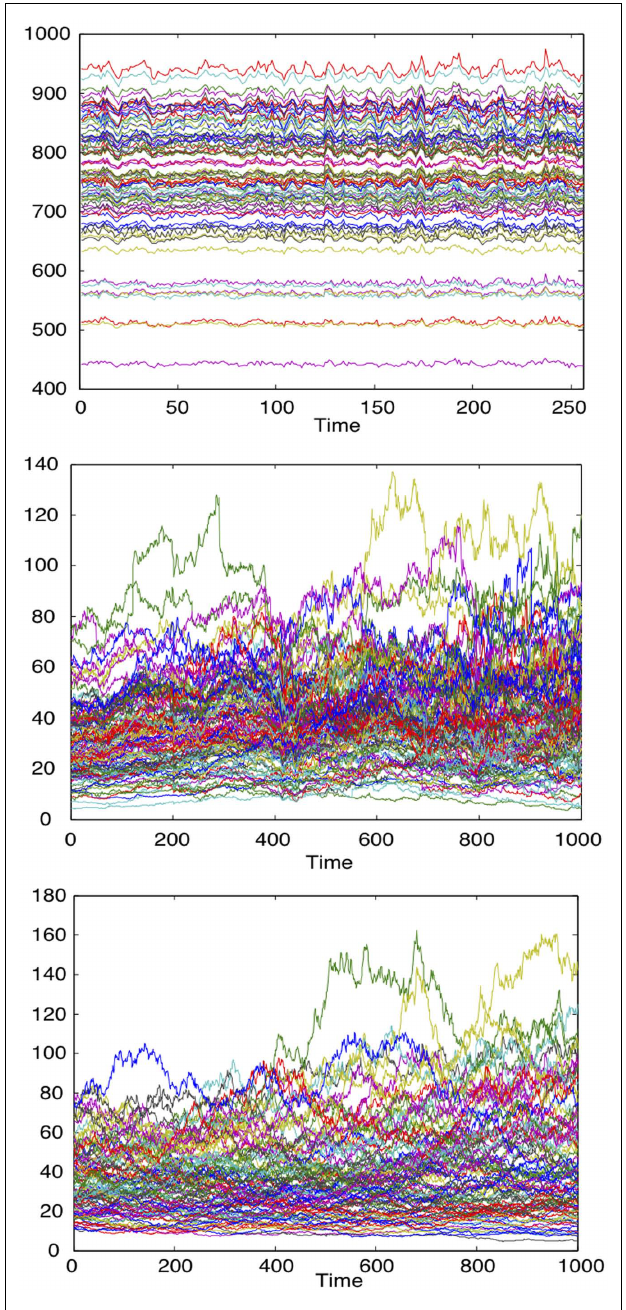
FIGUREA1 |Time series of fMRI data from 90 brain regions (top), time series for the daily closure price of 90 NYSE stocks (middle), time series for the stock price evolution, according to the Black-Scholes model, of 90 model stocks (bottom).